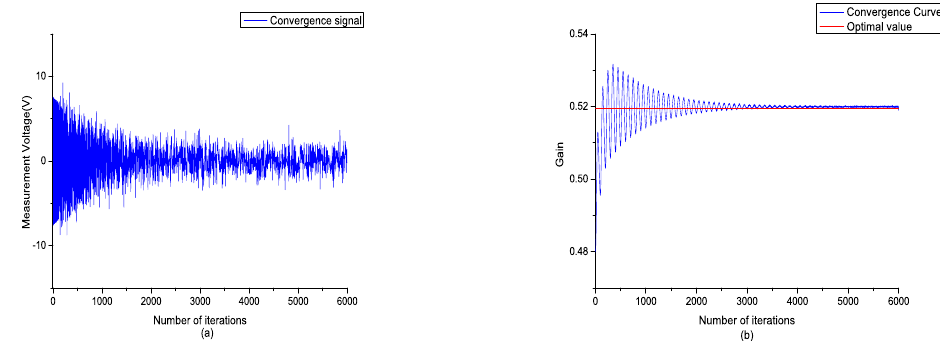
Figure 8. ( a ) Frequency domain steepest descent (FDSD) convergence signal of the measurement signal; ( b ) FDSD convergence curve of the positioner.